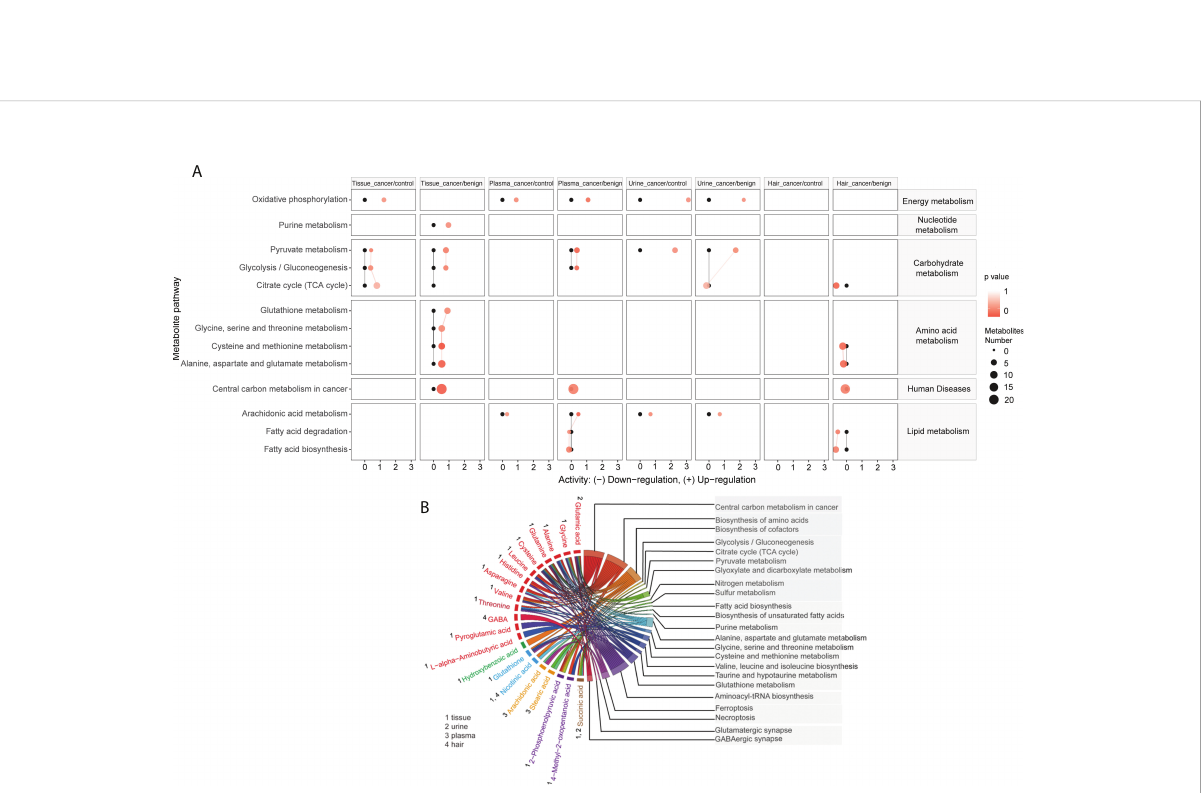
FIGURE 6 Metabolites are linked to different metabolic pathways. Activities of metabolic pathways in four samples (tissue, plasma, urine, and hair) based on the metabolome of patients. (A) Black dots represented metabolic activities in different samples (tissue, plasma, urine, and hair) from control patients that were adjusted to 0. Red dots represented metabolic activities in four samples from ovarian cancer compared to the control or benign ovarian tumor group. The metabolic activities were visualized using the log 2 scale. The dot size indicated the number of metabolites of the pathway, and the dot color indicated the p-value. A chord plot (B) displayed how the metabolites link to different metabolic pathways. Different colors represented different types of metabolites classi fi cation (red, amino acids and derivatives, green, benzene and substituted derivatives, blue, cofactors and vitamins, yellow, long-chain fatty acids, Purple, organic acids and derivatives, Burlywood, tricarboxylic acids and